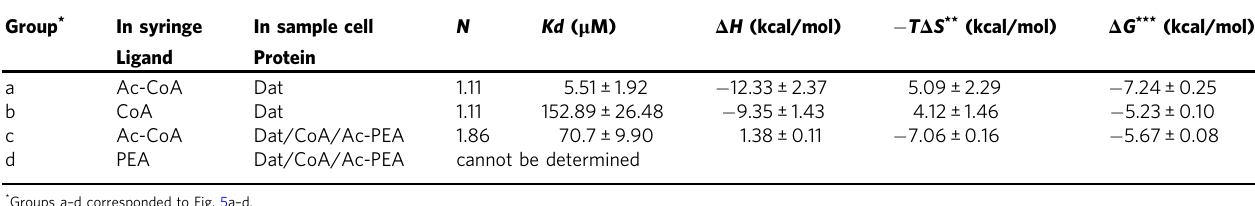
(Fig. 6c). 1 H- 15 N heteronuclear single quantum coherence (HSQC)